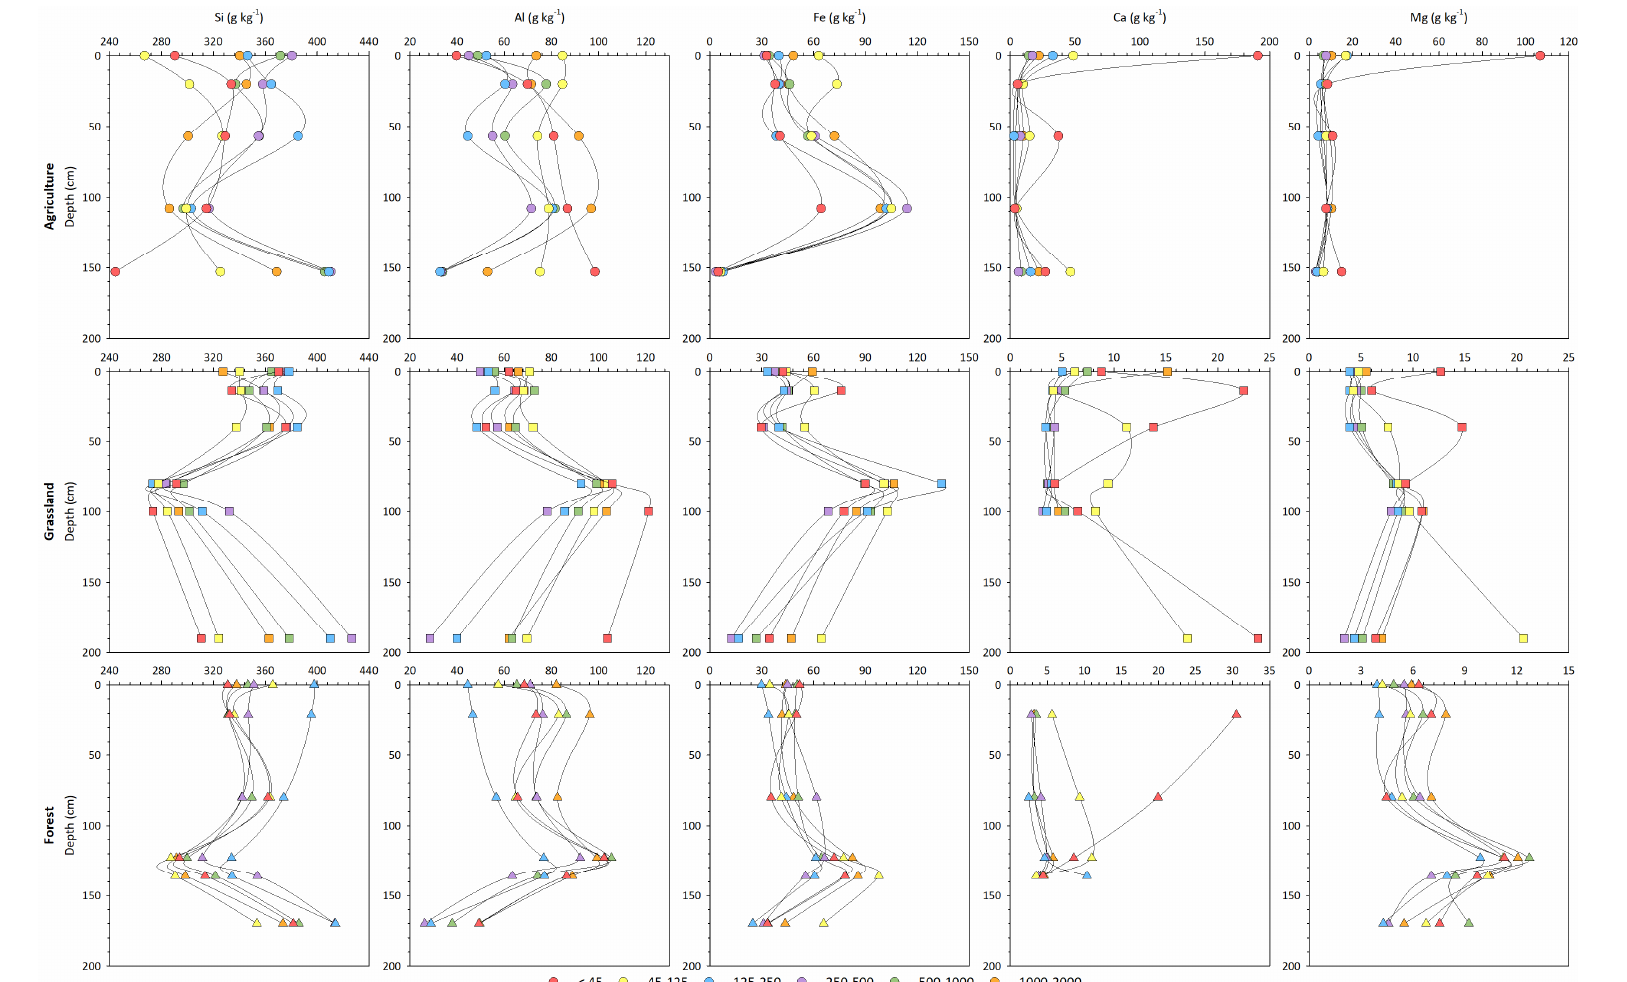
Figure 3. Surface-coated elemental concentrations (by EDS) for the six particle-size fractions of three sandy Alfisols under different land use. Note different x-axis scales for Ca and Mg.